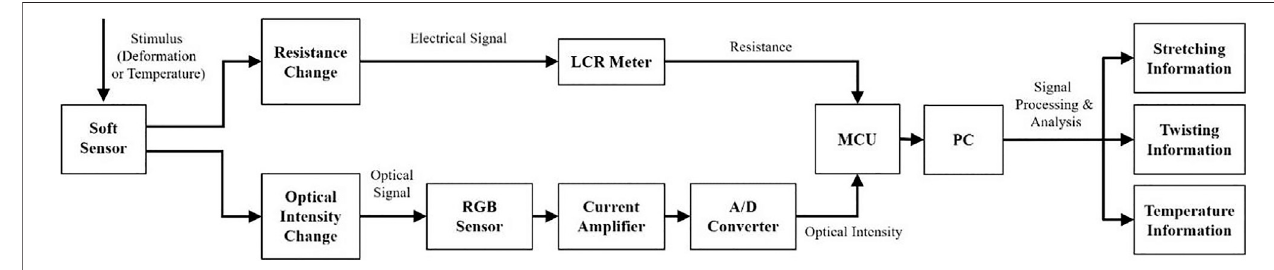
FIGURE 3 | The signals collection and processing scheme of the soft